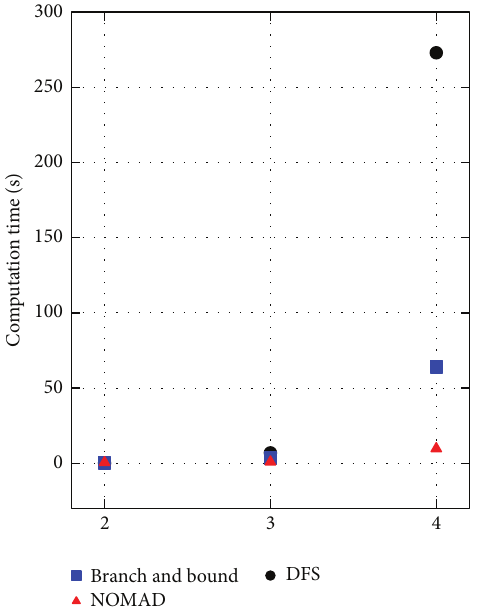
Figure 7: Scatter plot of execution times for algorithms higher resolution over smaller range (2–4 blanks).